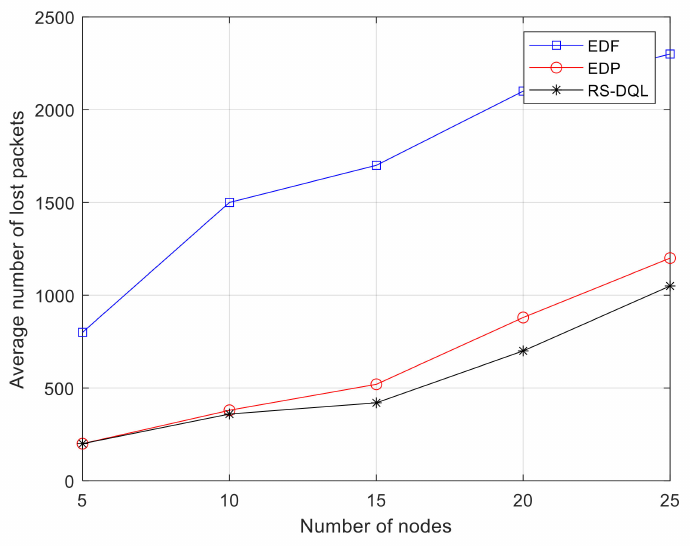
Figure 7. The number of lost packets as the sensor node